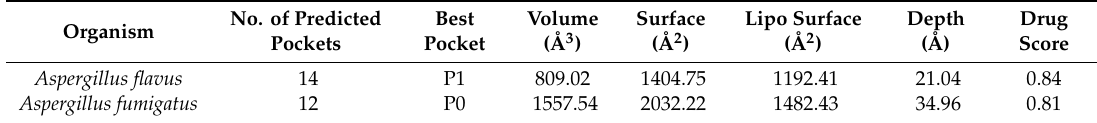
Table 2. Predicted binding pockets of the RNAP protein model from the DoGSite